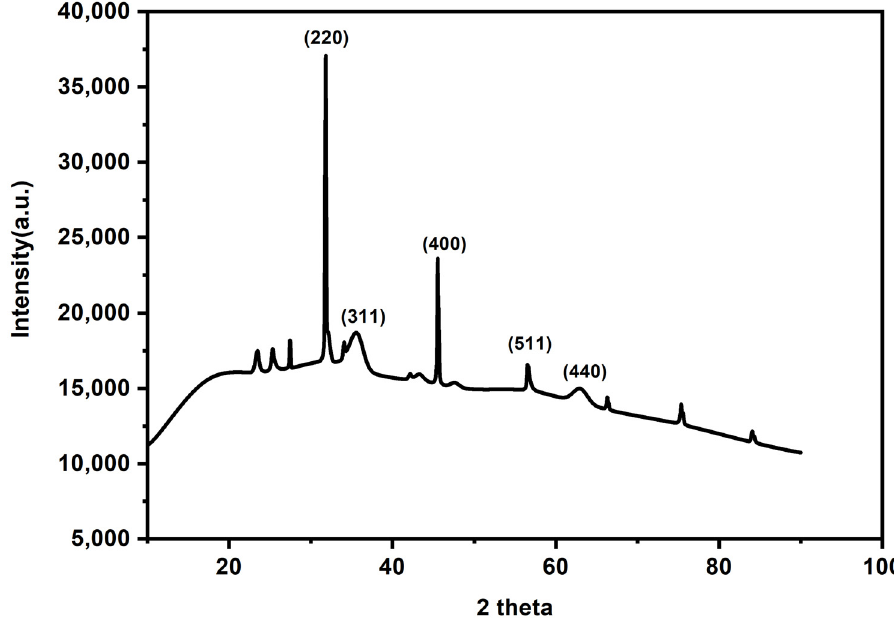
Figure 3. XRD diffraction pattern of the prepared adsorbent material.